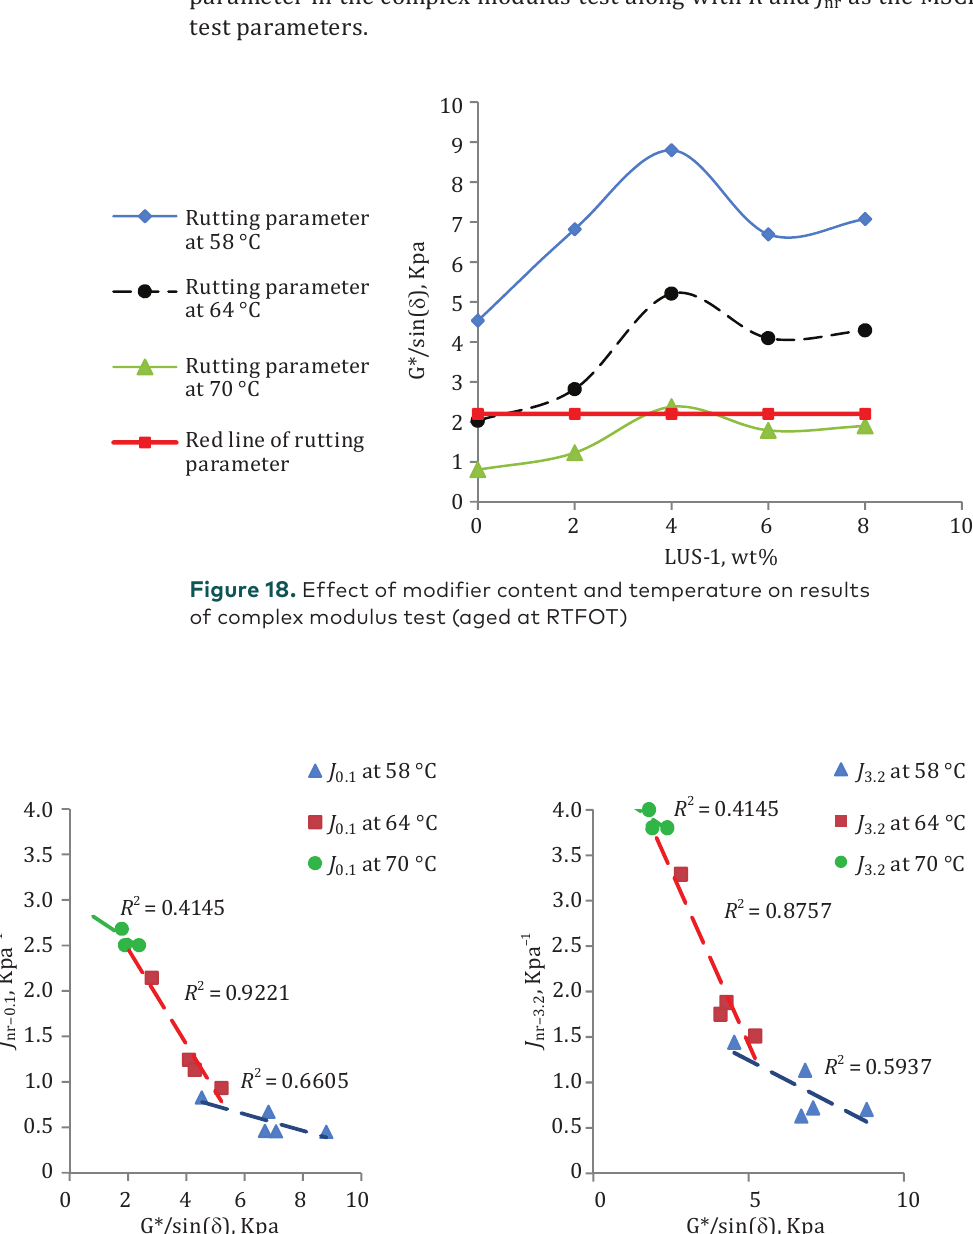
Figure 19. Linear correlation between G*/sin( d ) and J